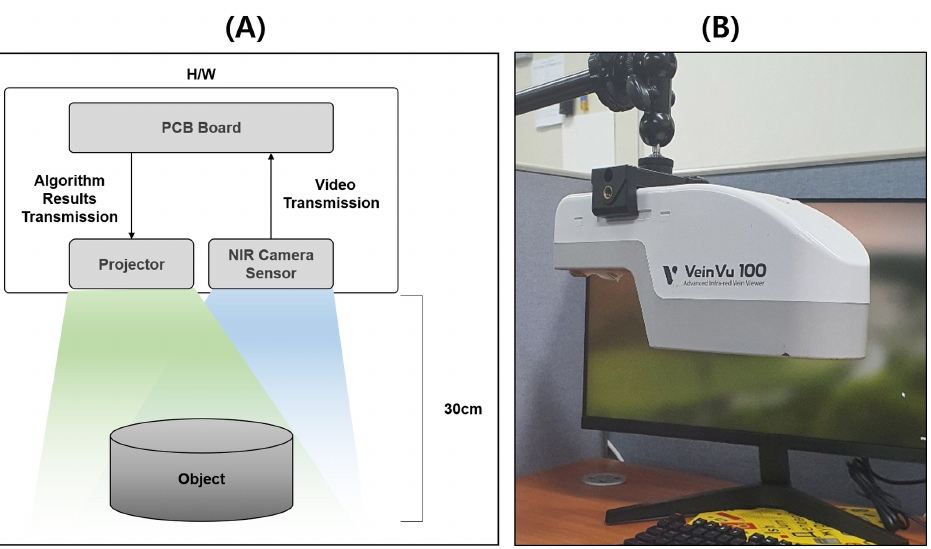
Figure 5. Structure of embedded vein projector: ( A ) is the structure of VeinVu-100 used in the proposed study, and ( B ) is an image of the device used.